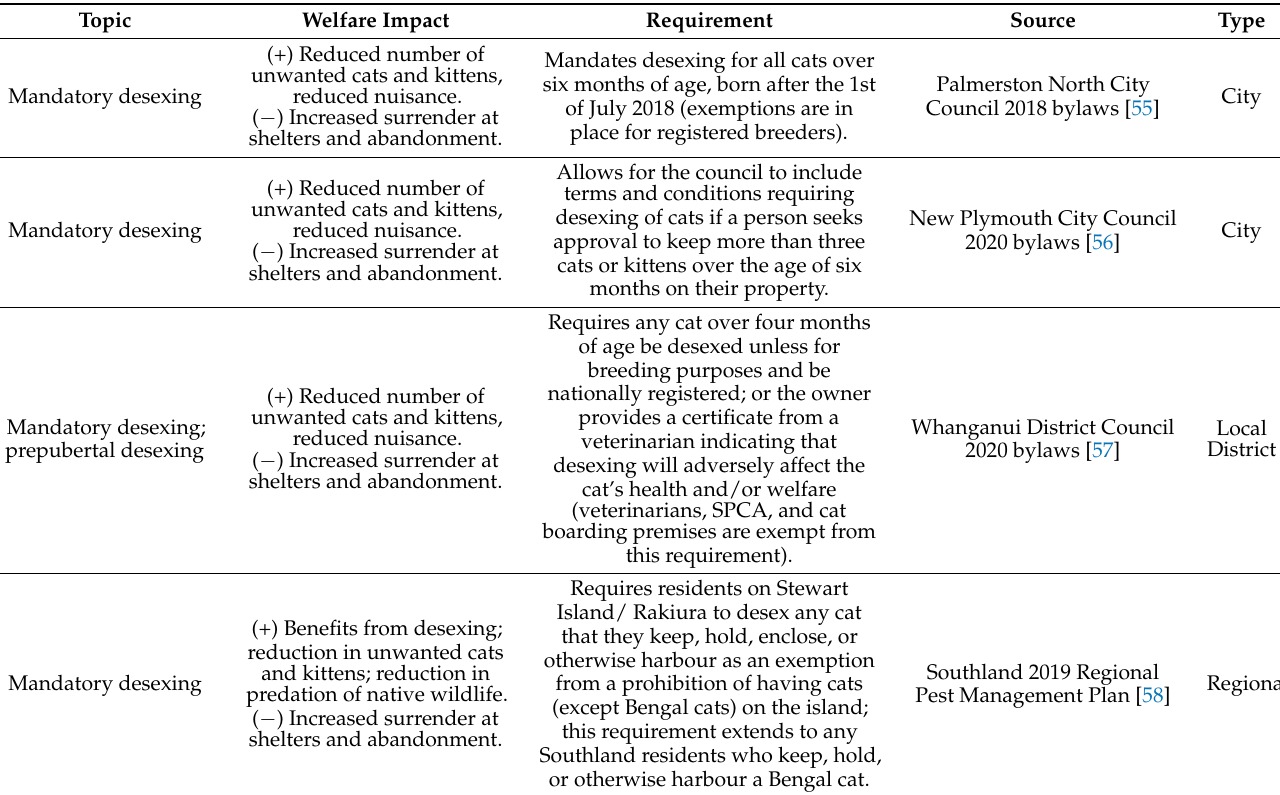
Table 2. Laws and regulations for